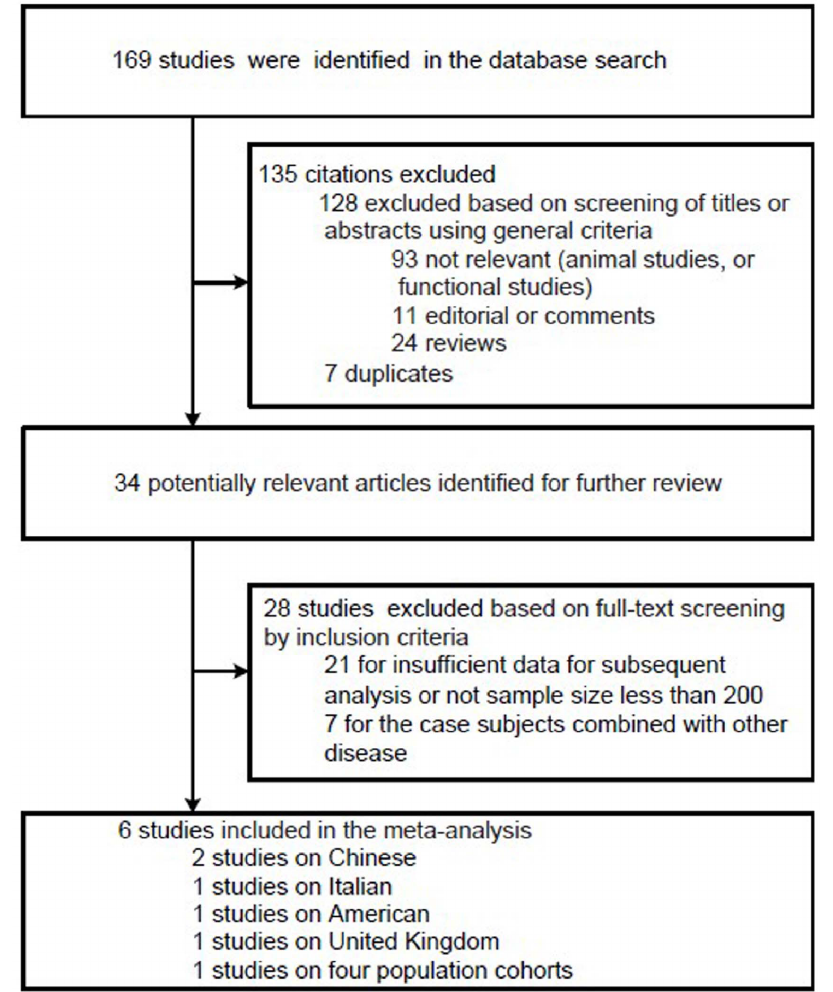
Figure 1. Flow chart for the process of selecting eligible publications.